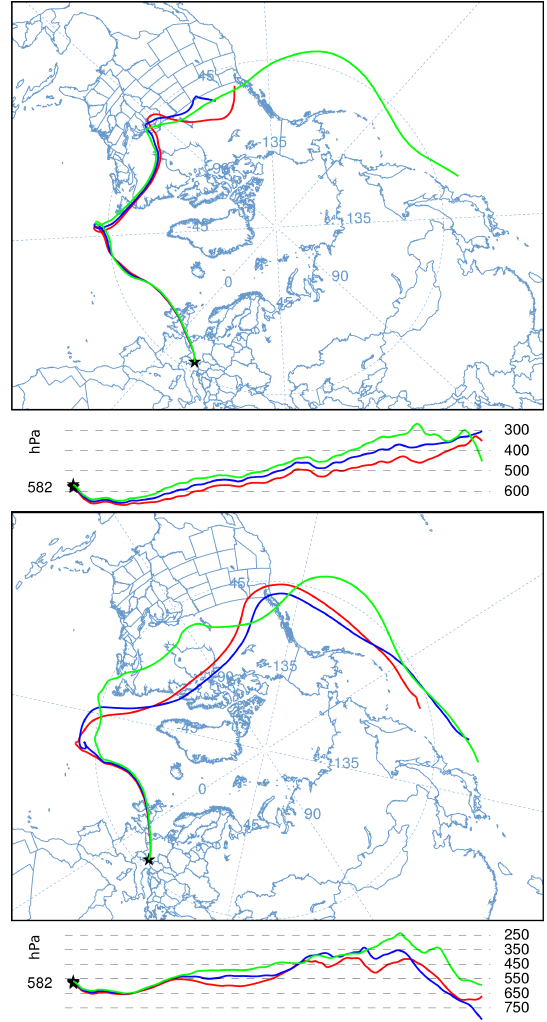
Figure 12. Backward trajectories from the NOAA HYSPLIT model (see text) ending above the Zugspitze at 4600, 4700 and 4800m a.s.l. at 06:00UTC (upper plot) and 08:00UTC (lower plot), 29 July 2009 were calculated from reanalysis data with a vertical velocity model and a duration of 315h. The vertical sections are referred to the air pressure along the pathways. The remarkable coherence of the three pathways during a longer time indicates a rather good